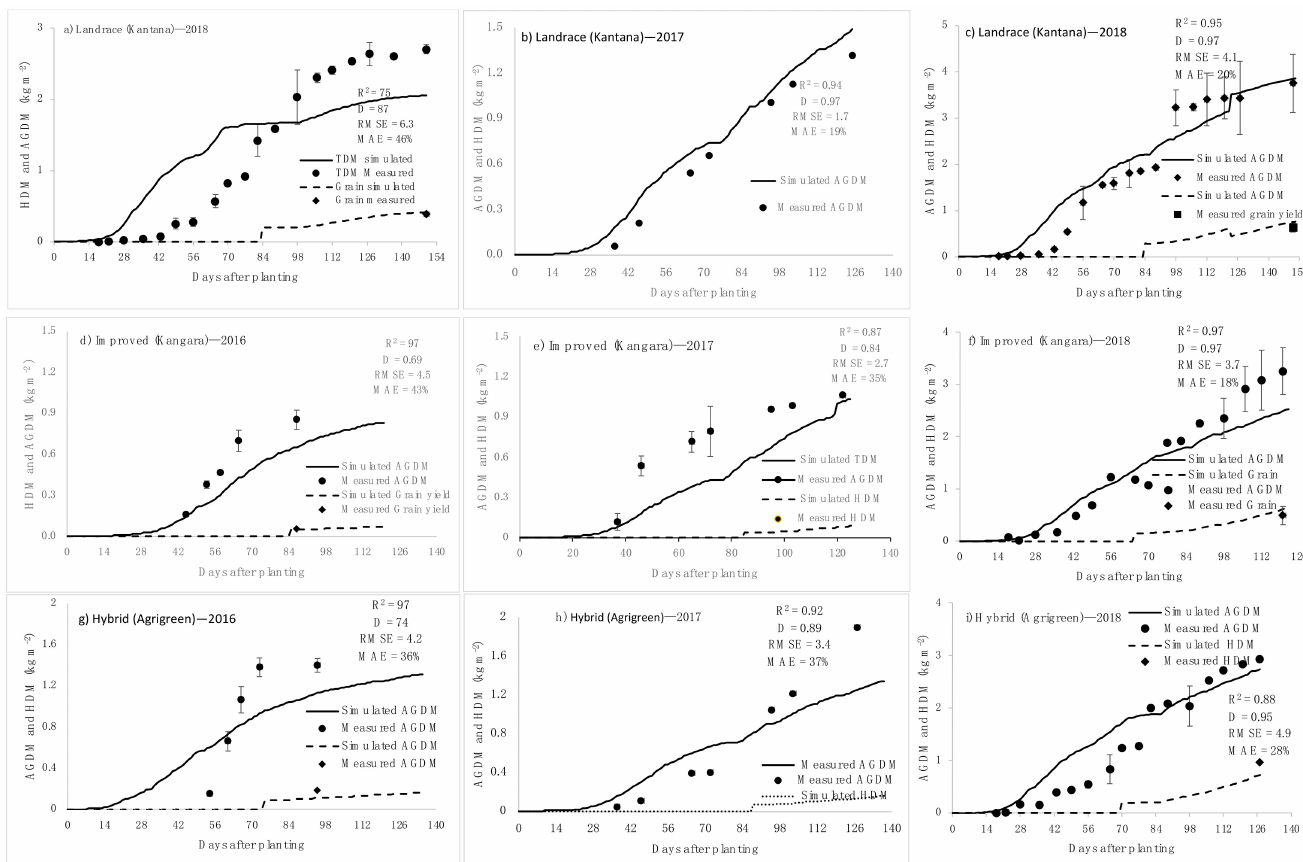
Figure 7. Simulated (solid lines) and measured (points) harvestable dry matter (HDM) and above- ground dry matter (AGDM). Landrace (Kantana): ( a ) 2018 rainfed, ( b ) 2017, ( c ) 2018. Improved (Kangara): ( d ) 2016, ( e ) 2017, ( f ) 2018. Hybrid (Agrigreen): ( g ) 2016, ( h ) 2017, ( i ) 2018. All three varieties were irrigated fortnightly every season excluding ( a